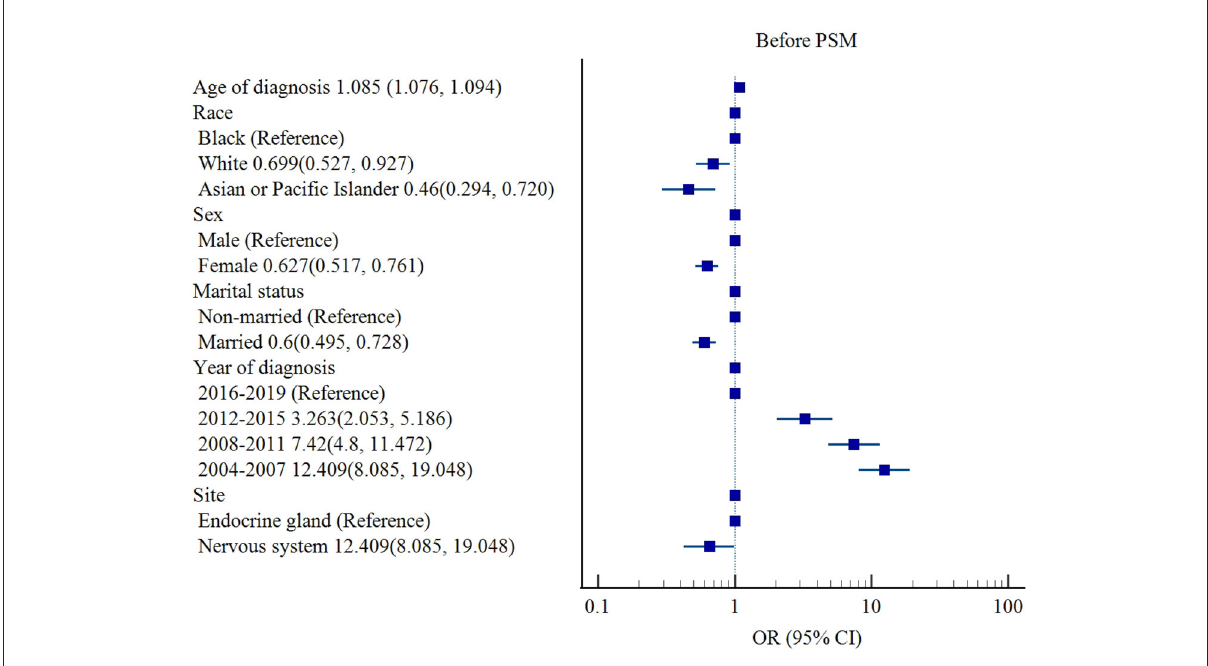
FIGURE2 Influencing factors of cardiac-specific death in patients with non-malignant tumors of CNS receiving RT before PSM.